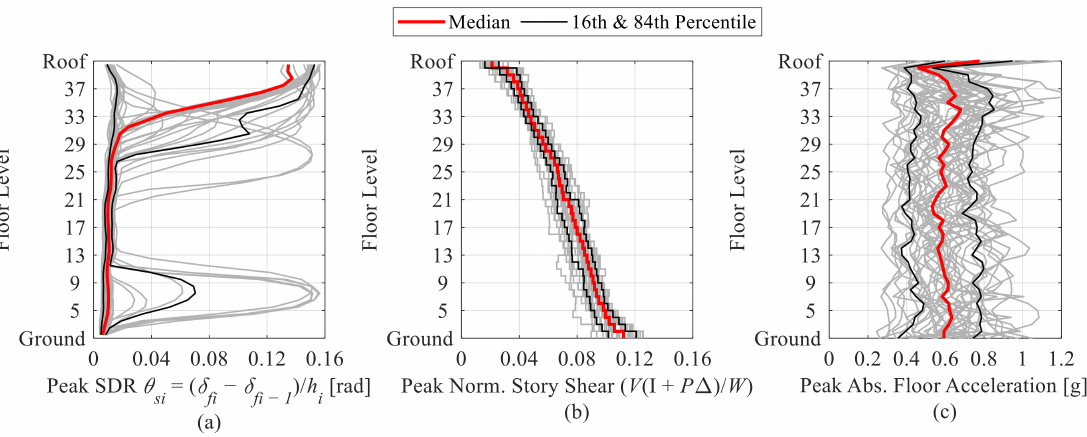
Figure 5. Engineering demand parameters in the X-loading direction (BSE-2E), ( a ) peak SDR, ( b ) peak normalized story shear force, ( c ) peak absolute floor